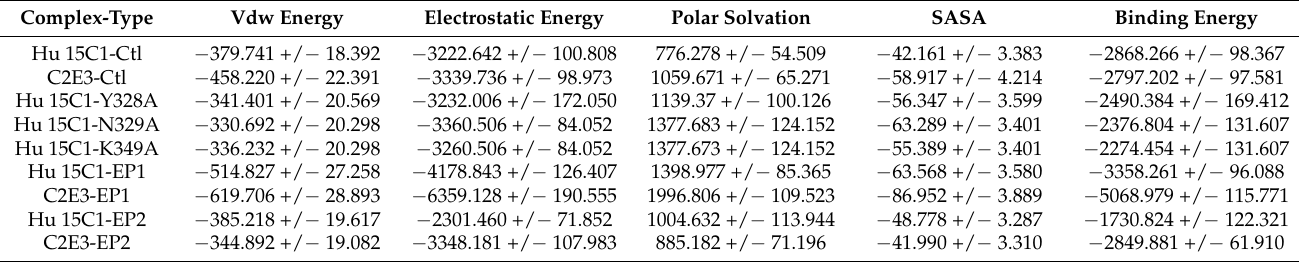
Table 1. Binding free energy of Hu 15C1 and C2E3 toward